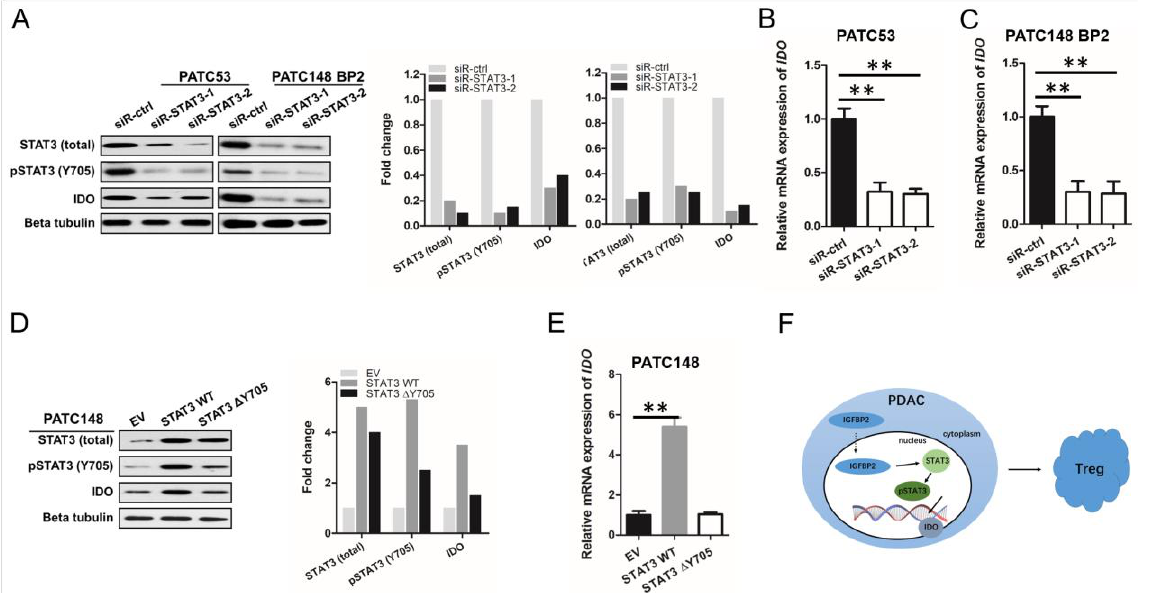
Figure 6. IGFBP2 induces IDO production in human PDAC cells via STAT3 signaling. ( A ) Western blot of high endogenous IGFBP2 MDA-PATC53 cells or IGFBP2-overexpressing PATC148 BP2 after transfection with negative control (siR-ctrl) and STAT3 (siR-STAT3-1 and -2) siRNAs, respectively. STAT3, pSTAT3, and IDO protein amounts were assessed by Western blot, with beta tubulin as a reference protein. IDO mRNA amounts ( B , C ) in the above cells were assessed by qRT-PCR, with GAPDH as a reference gene (** p < 0.01 by ANOVA). ( D ) Low endogenous IGFBP2 MDA-PATC148 cells underwent transfection with wild type and Y705-mutant STAT3 plasmids, respectively. The protein levels of STAT3, pSTAT3 and IDO were assessed by Western blot, with beta tubulin as a reference protein. IDO mRNA amounts ( E ) in the latter cells were determined by qRT-PCR, with GAPDH utilized for normalization (** p < 0.01 by ANOVA). Data are mean ± SD from 3 or more assays performed independently. ( F ) IGFBP2 promotes tumor progression via alternative polariza- tion of macrophages in PDAC in a STAT3 pathway-dependent manner.